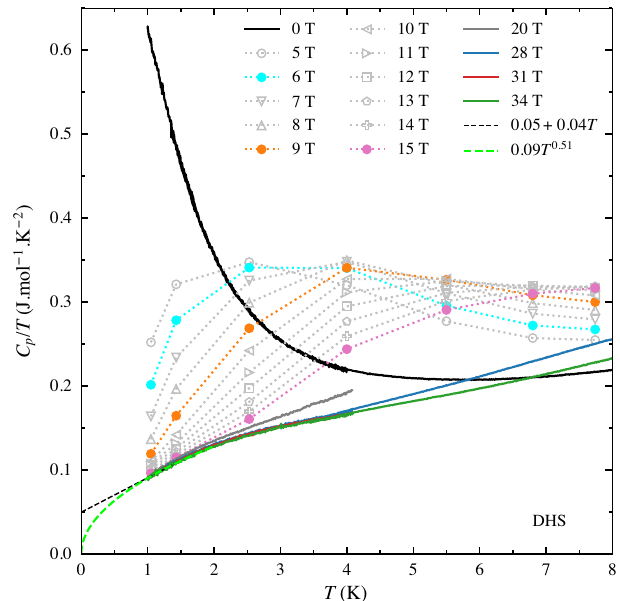
=T data obtained at 16 selected field values for FIG. 2. The C p temperatures 1 ≤ T ≤ 8 K on the DHS single crystal. The discontinuous data sets are extracted from field scans at fixed temperatures. Some of the extrapolations from Fig. 1 are reproduced